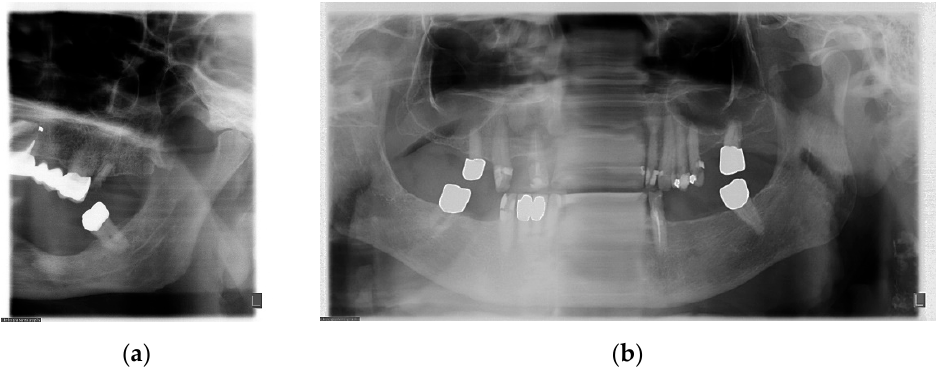
Figure 9. Incomplete acquisition: ( a ) X-ray tube halts against the patient’s right shoulder during the initial phase of the tube rotation. Only the posterior structures of the left side are represented in the image. ( b ) Slowing down without stopping the X-ray tube because of patient’s humpback. The initial and end phases of the tube rotation do not slow down with consequent normal visualization of the left and right posterior areas, respectively.